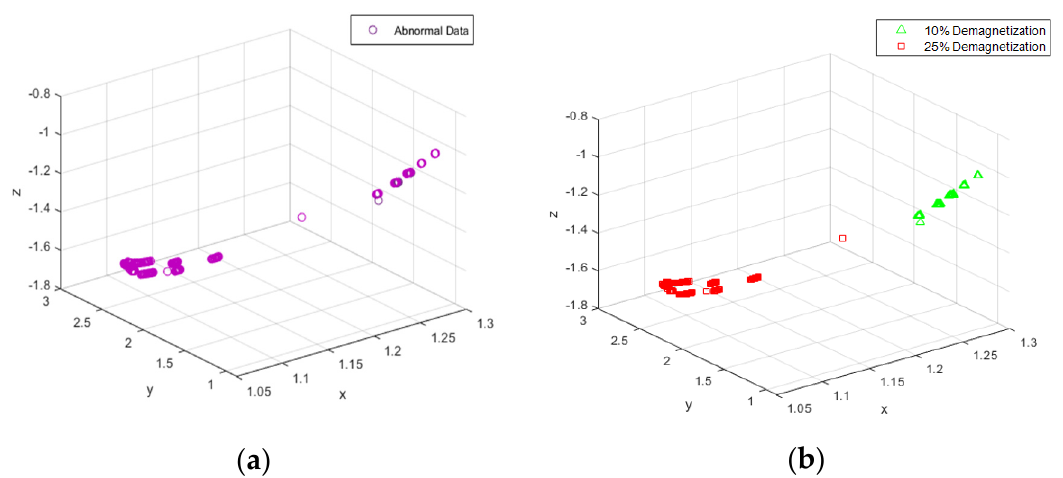
Figure 10. Clustering: ( a ) data considered abnormal in anomaly detection and ( b ) results of clustering. Table 8. Accuracy of clustering. Table 7. Confusion matrix of clustering.